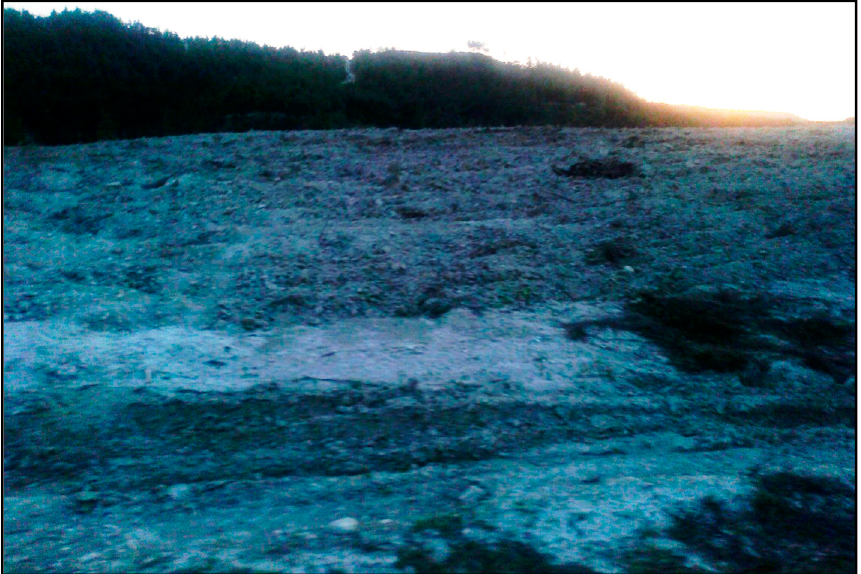
Figure 8. Photo of the burned forests changed into farmland in the Syrian ‐ Turkish border area (Yamada), 22 October 2013.